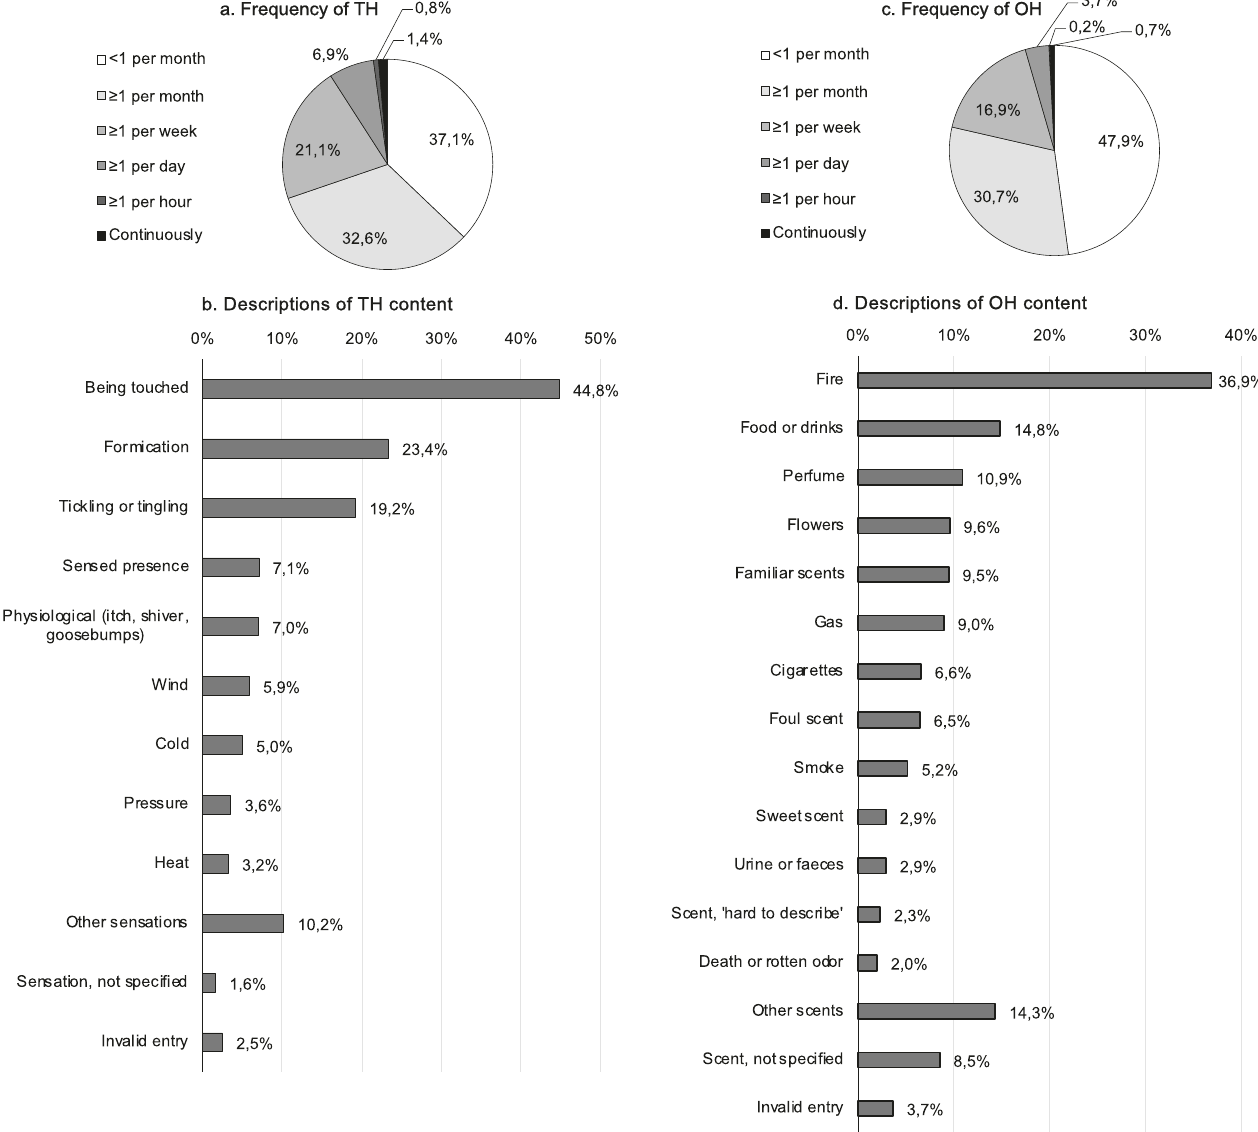
Fig. 4 Phenomenology of tactile and olfactory hallucinations in the past month. Phenomenology of tactile hallucinations ( a , b ) and olfactory hallucinations ( c , d ) in the past month. Total n (TH) = 2077; total n (OH) = 1807. Additional phenomenological items are listed in Supplementary Fig. 5. Data are listed per QPE item, as obtained through multiple choice items with one answer possibility ( a , c ) and open questions, asking participants to describe the experienced content of TH ( b ) or OH ( d ). Some descriptions of TH contained terms that may be dif fi cult to distinguish from regular physiological reactions to internal or external stimuli, such as itch, pain, shivers, or goosebumps, and were therefore categorized as ‘ physiological ’ . Invalid entries TH: likely external source ( n = 5); incomplete or incomprehensible information ( n = 47). Invalid entries OH ( d ): likely external source ( n = 24); incomplete or incomprehensible information ( n =